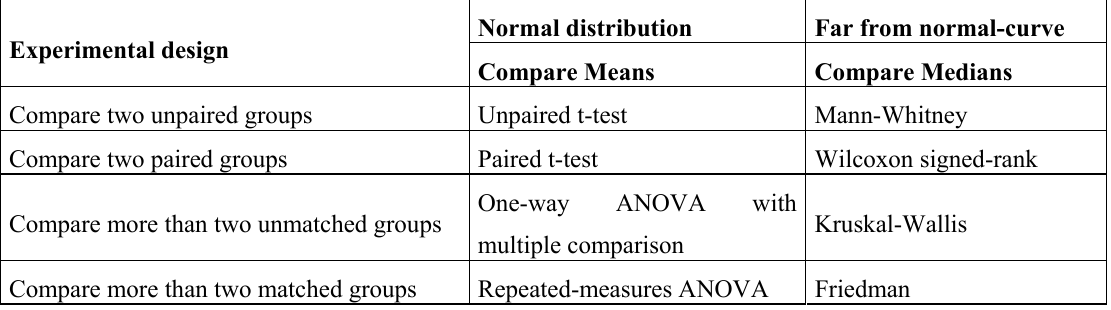
Table 2. Best suited statistical tests for datasets following normal distribution or far from the normal curve according to their experimental